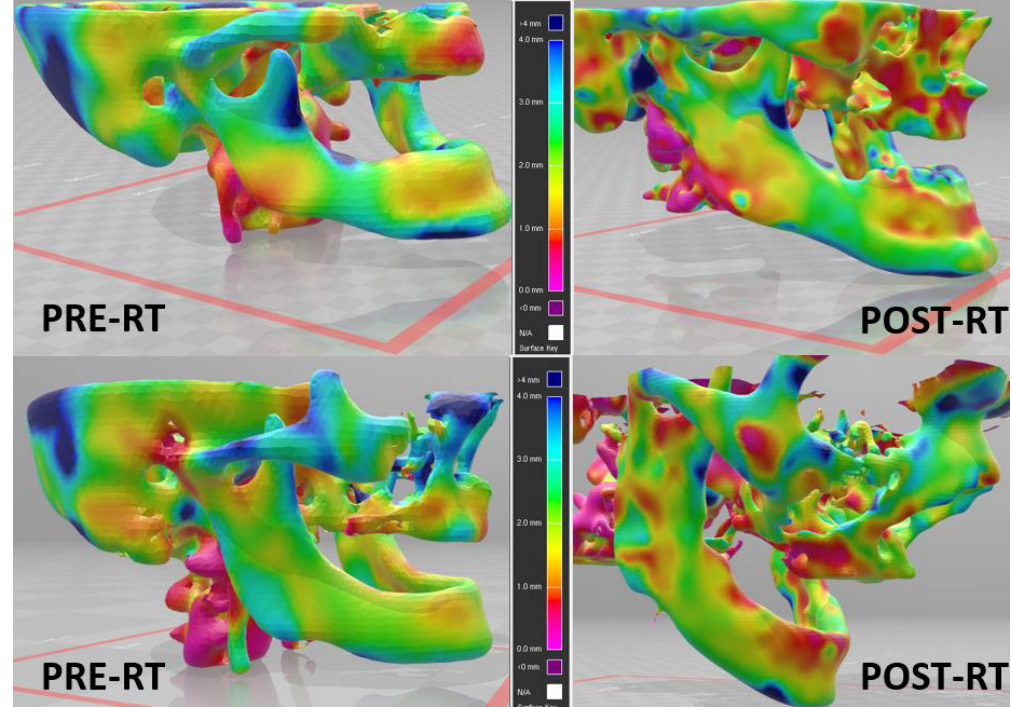
Figure 2. Early cortical bone thickness loss after radiation therapy (RT) for two patients with oropharyngeal squamous cell carcinoma treated with chemo-radiotherapy. Left: pre-RT, right: post-RT (median 90 days after end of RT).